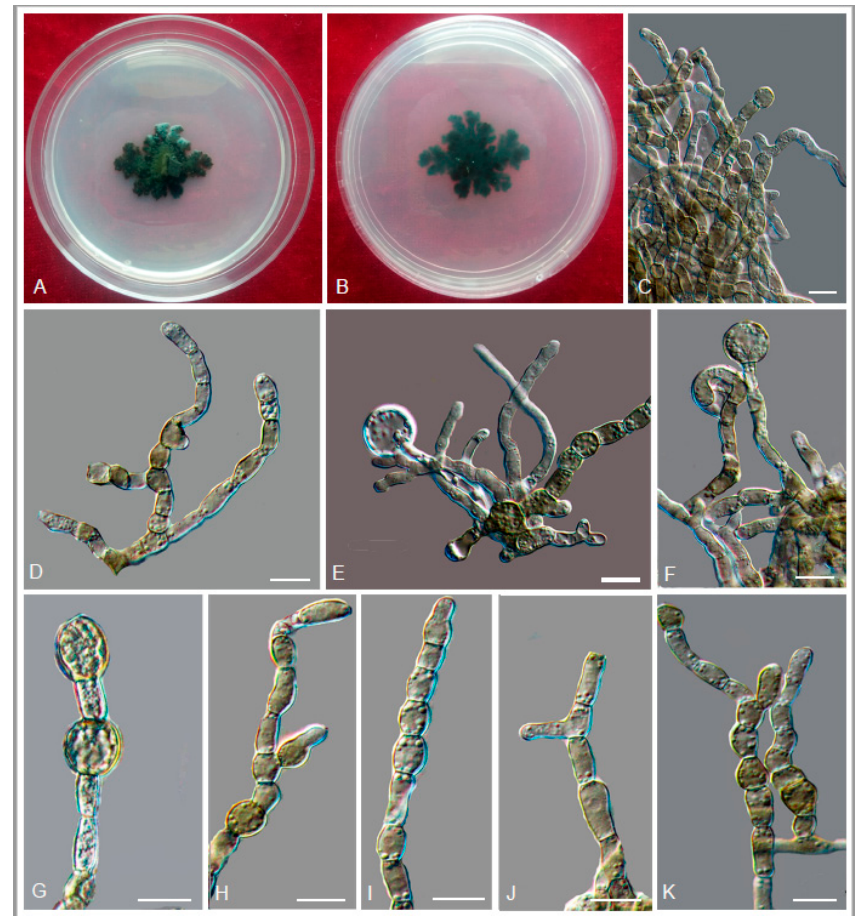
Figure 6. Anthracina ramosa (CGMCC3.16372). ( A , B ) Colony forward and reverse after 20 weeks on malt extract agar (MEA). ( C , D , H – K ) Moniliform and cylindrical celled hyphae. ( E – G ) Terminal and intercalary swollen cells. Scale bars ( C – K ) = 10 μ m.